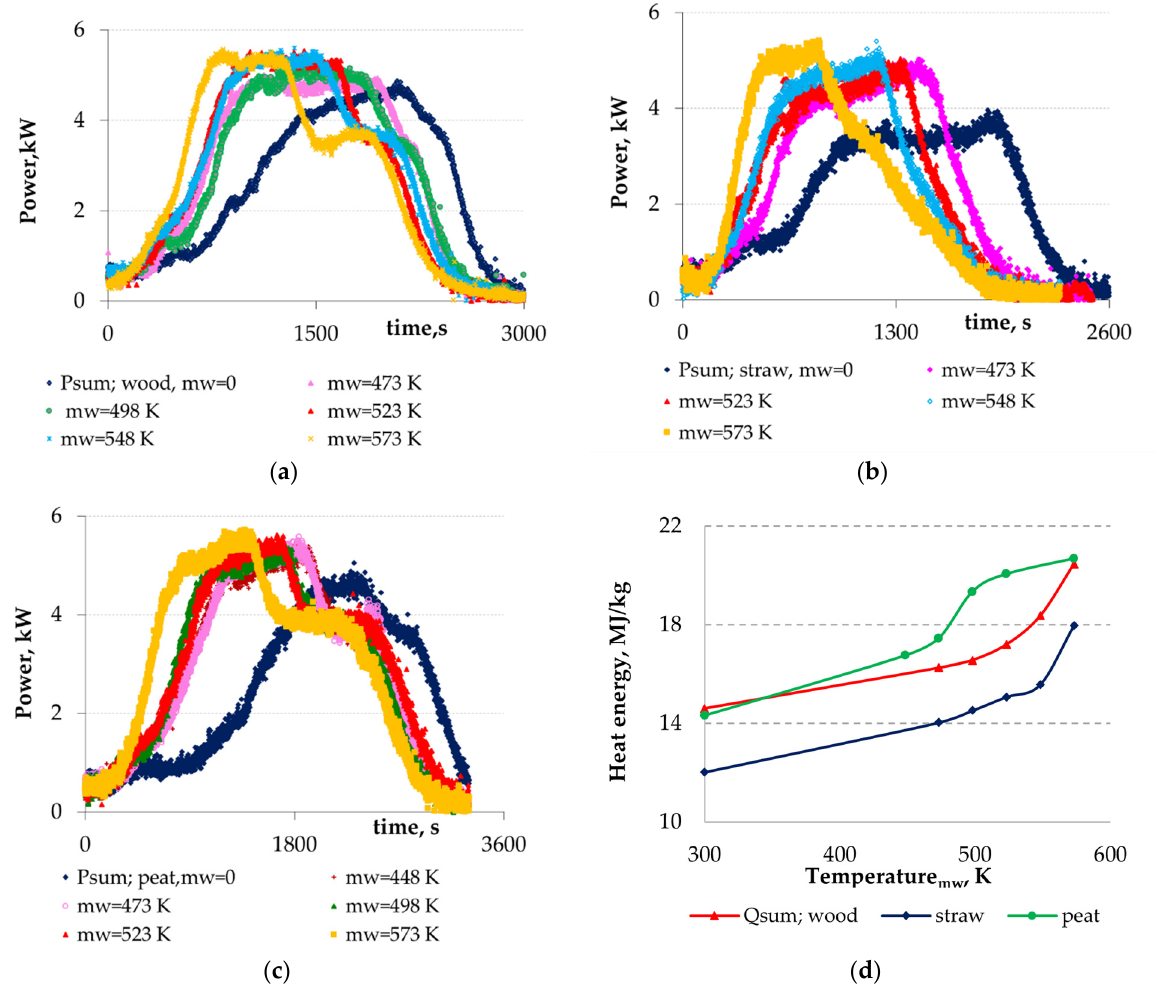
Figure 9. The effect of the mw pretreatment temperature on the kinetics of the heat power output ( a – c ) and produced heat energy per mass of pretreated pellets ( d ) during the burnout of wood ( a ), wheat straw ( b ) and peat pellets ( c ).